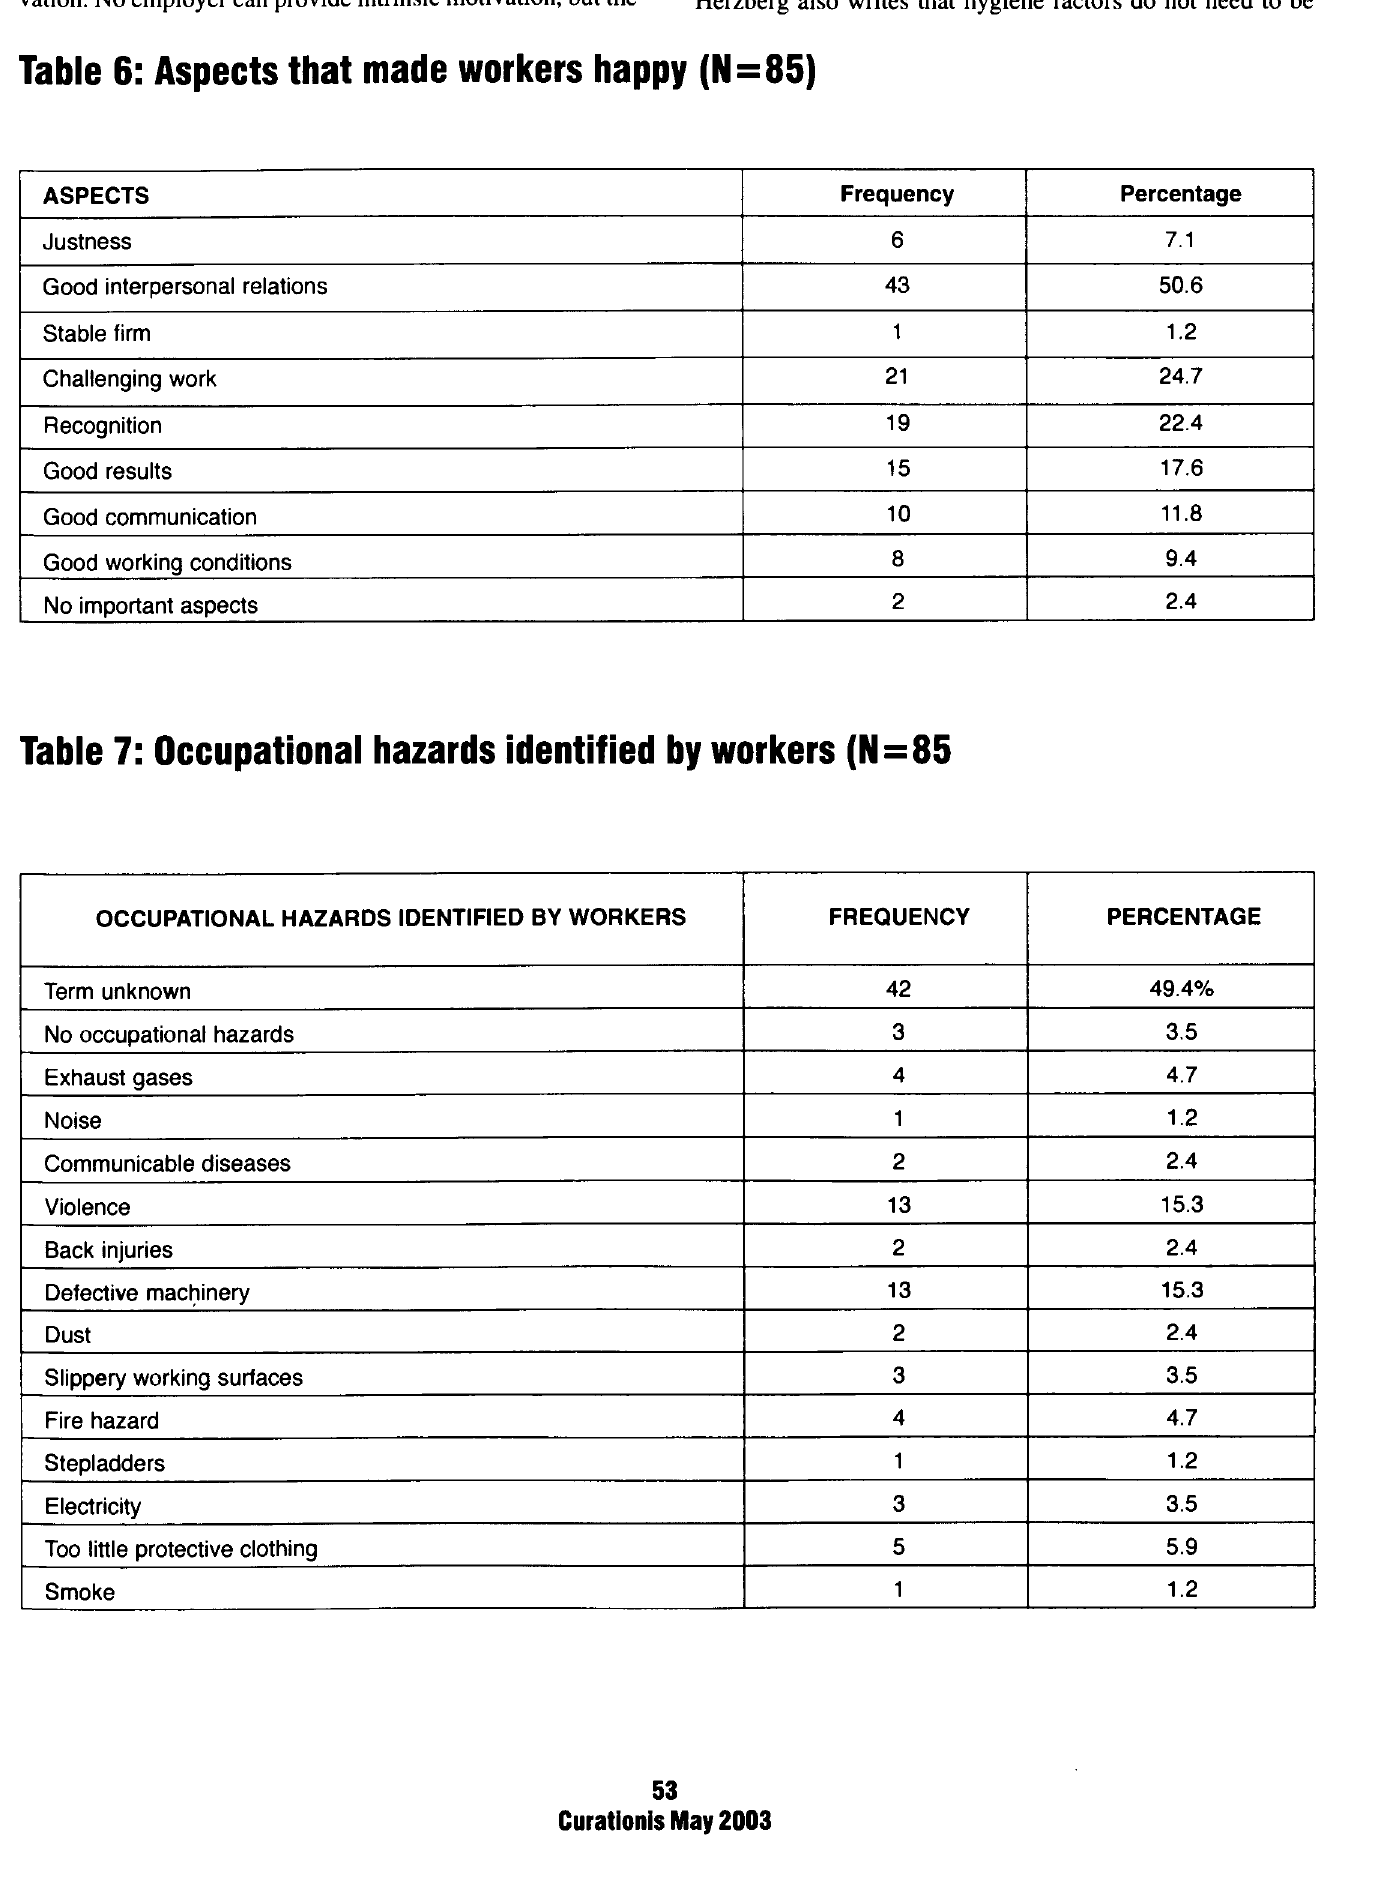
Table 6: Aspects that made workers happy (N=85) ASPECTS